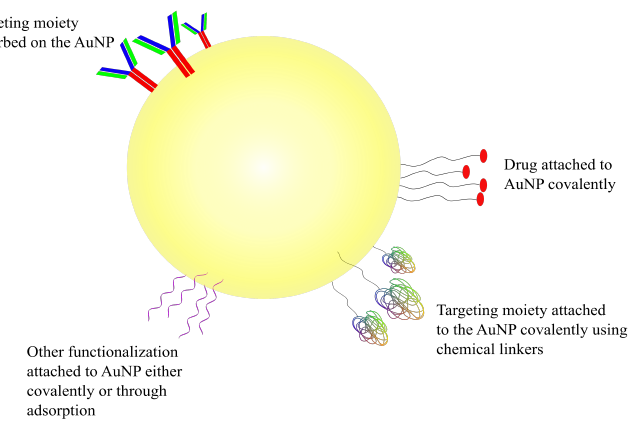
Figure 4. Schematic representation of a gold nanoparticle. Drugs and other functionalizations can be adsorbed or covalently attached onto AuNPs’ negatively charged